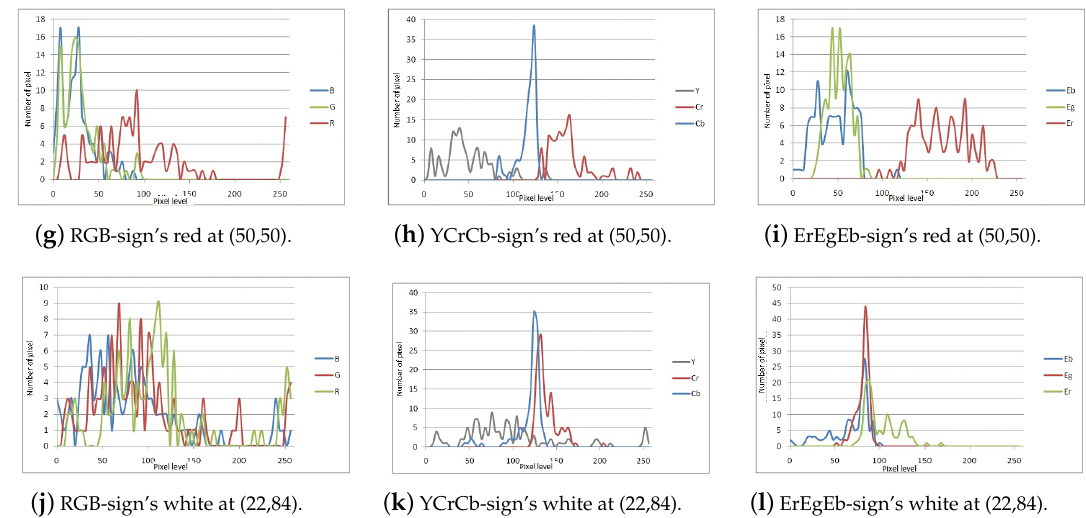
Figure 8. Histograms in three color spaces for pixels in the reference areas of Figure 7.